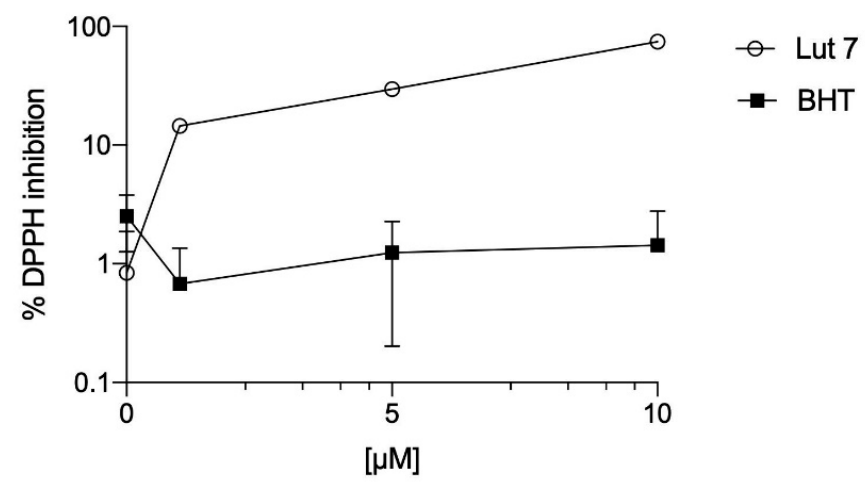
Figure 2. DPPH scavenging ability of Lut 7 and BHT—dose response analysis.